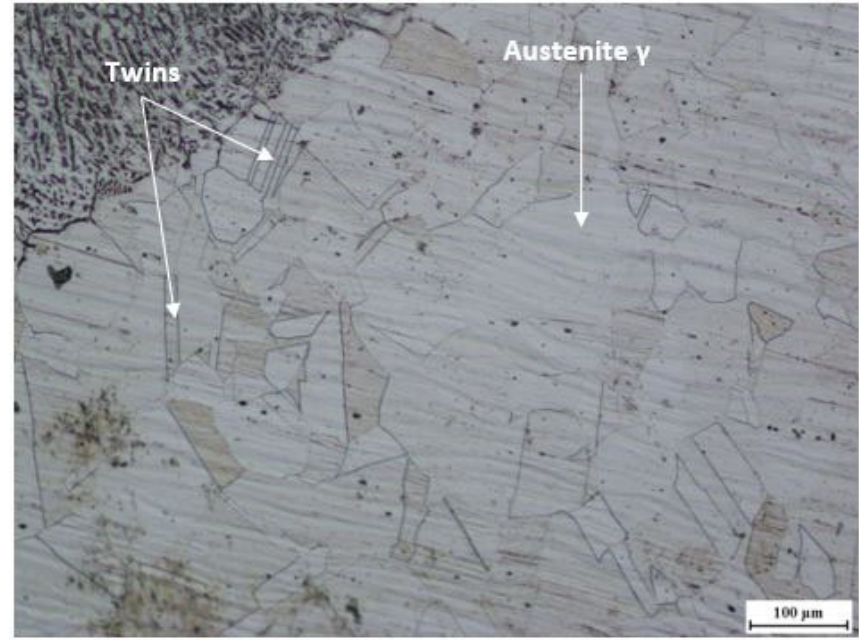
Figure 17. Optical micrograph of the HAZ for 304 austenitic stainless steel.